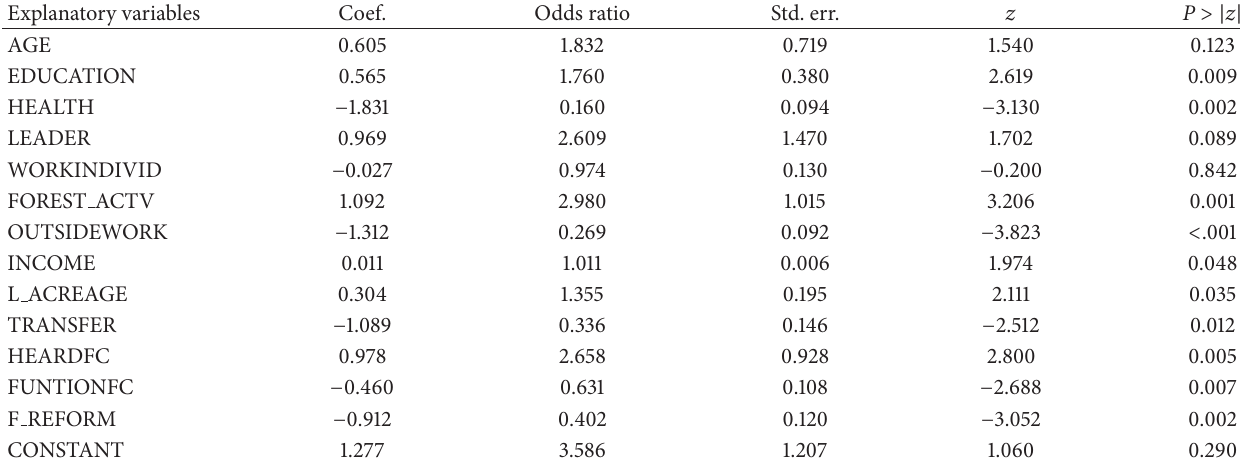
Table 5: Results of logistic regression on willingness-to-participate in forest cooperatives as a function of selected explanatory variables. Explanatory variables Coef. Odds